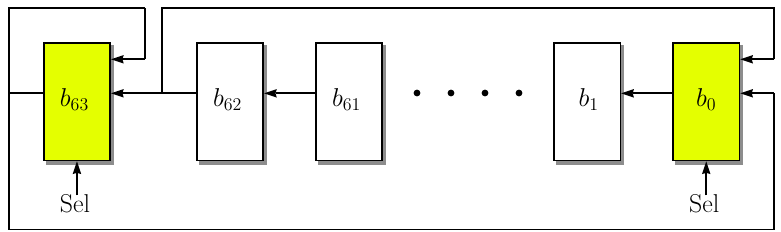
Figure 1: Shift register circuit with (subsequent) 2 scan